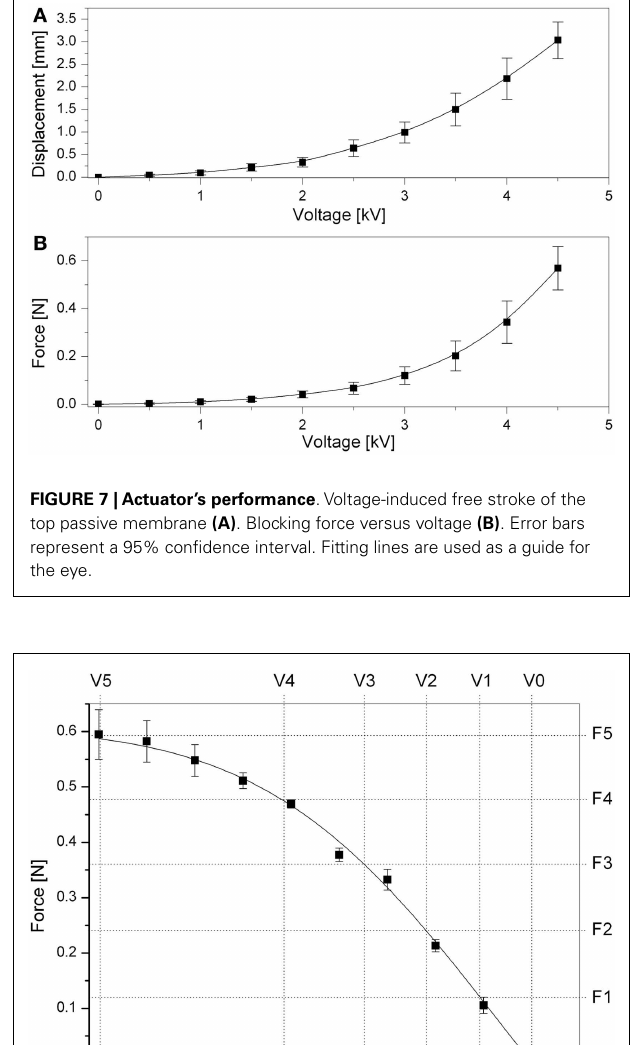
Their values were extrapolated from the curve used to interpolate the experimental